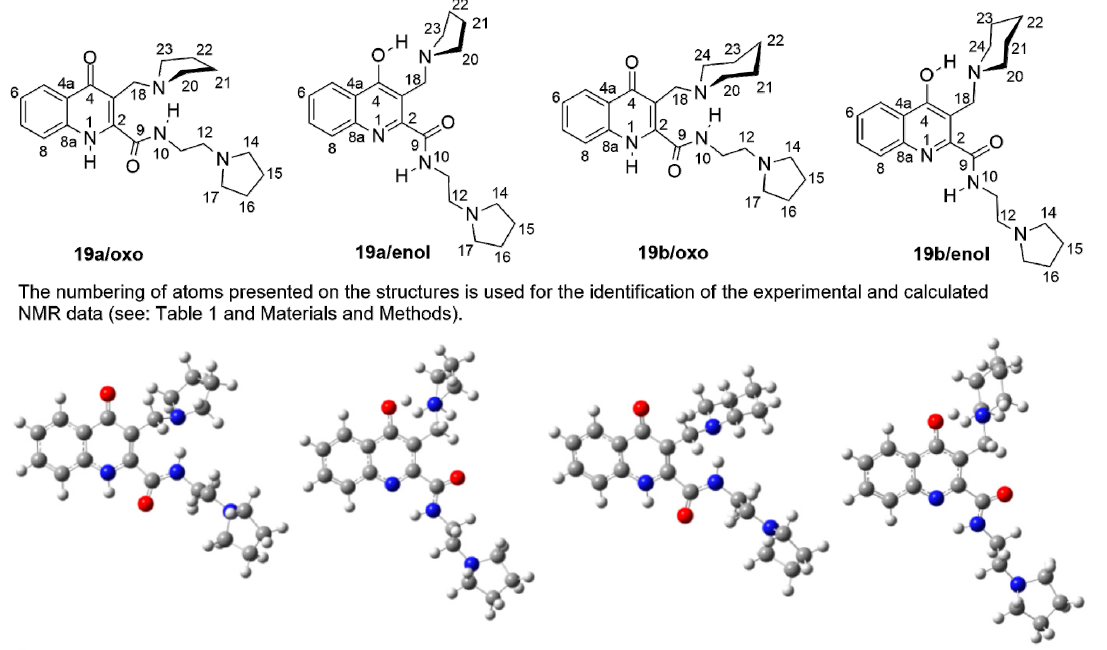
Figure 1. Optimised structures of the oxo- and enol forms of representative KYNA amides 19a , b with the numbering of atoms used for the assignment of the experimental and calculated NMR data. Table 1. Diagnostic 1 H- and 13 C chemical shifts measured for 19a , b and calculated for the corresponding oxo- and enol forms by GIAO method a . 19a 19b oxo enol Experimental oxo enol Experimental 1 H- 1 H- and 13 C Calculated 1 H- Calculated 1 H- Calculated 1 H- Calculated 1 H- and 13 C NMR and 13 C NMR and 13 C NMR NMR Chemical and 13 C NMR and 13 C NMR Chemical Shift Chemical Shift Chemical Shift Shift Chemical Shift Chemical Shift XH